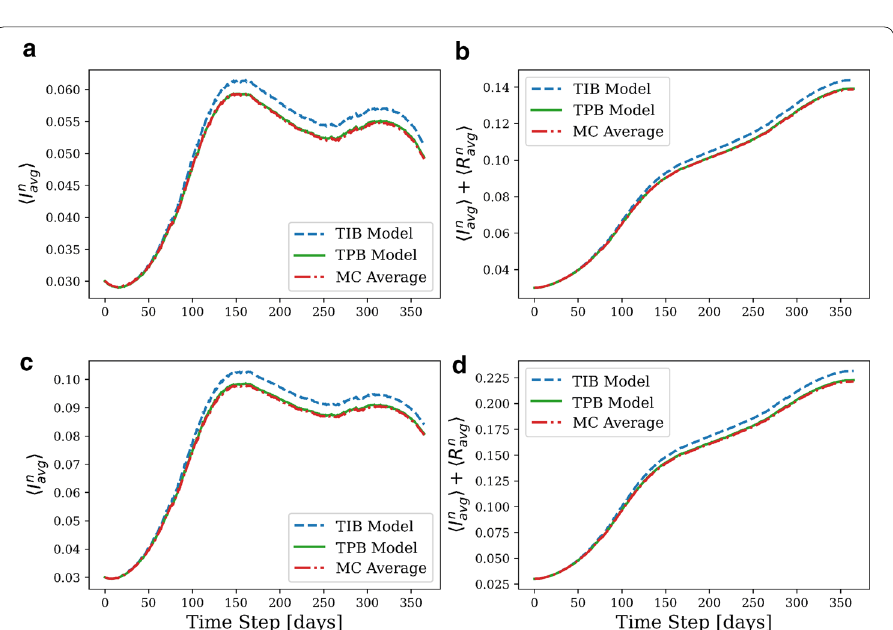
Fig. 4 TIB (blue dashed) and TPB (green solid) SIR models on the Irish cattle trade network together with the average of 10 3 Monte-Carlo simulations (red dash-dotted). a , c The time series for the prevalence of infection in the network and b , d the cumulative prevalence of infection within the network. The probability of infection is set to β = 0.3 in a , b and β = 0.5 in c , d . The initial chance of infection is 0.03. Other parameters: µ =